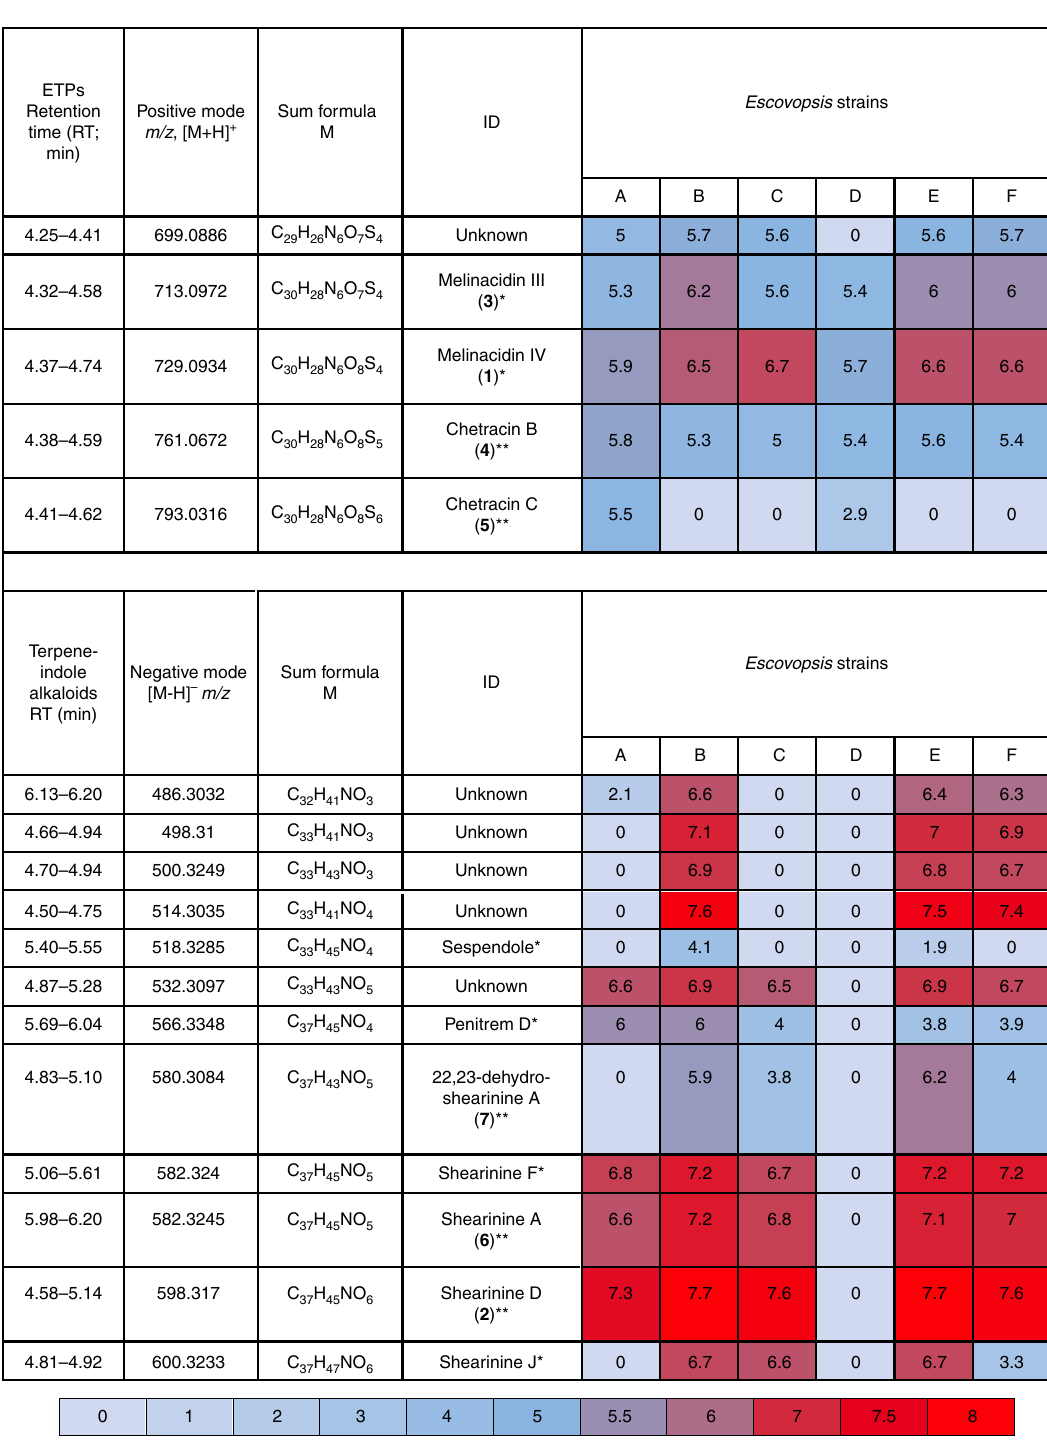
Fig. 5 List of selected signals assigned to ETPs and shearinine-like terpene-indole alkaloid metabolites. Includes a heat map of their average ion count in logarithmic representation. *Metabolite putatively annotated; **metabolite identi fi ed and authenticated against isolated sample + [M + H] , molecular formula of C 29 H 26 N 6 O 7 S 4 ). Two related signals could be annotated as the ETPs chetracin B ( 4 ; m/z + , molecular formula of C 30 H 28 N 6 O 8 S 5 ; Sup- 761.0670 [M + H] plementary Note 4) and chetracin C ( 5 ; m/z 793.0639 [M + H] + , molecular formula of C 30 H 28 N 6 O 8 S 6 ; Supplementary Note 5) which was veri fi ed by NMR 41 . ETPs 4 and 5 feature polysul fi de bridges of their diketopiperazine moiety of various lengths and are present in lower amounts in the extracts 42 (Fig. 3). NATURE COMMUNICATIONS | (2018) 9:2208 | DOI: 10.1038/s41467-018-04520-1 |